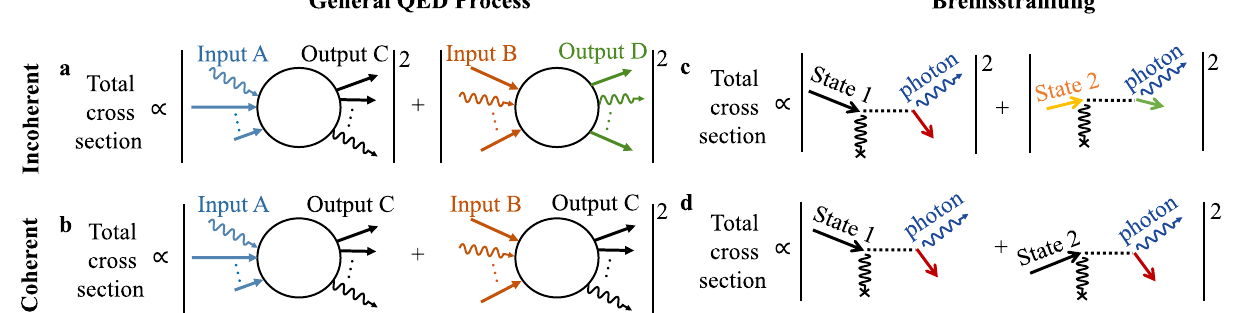
Fig. 1 Coherent and incoherent contributions in quantum electrodynamical (QED) processes. When the input to a QED process is a superposition of multiple states, e.g., 2 states (Input A and Input B), the overall cross section is typically given by the sum of the cross sections associated with each input state, as in ( a ). Then, the total cross section is proportional to the sum of the squared-modulus of all the respective scattering amplitudes. However, when the input states are chosen to yield the same output state C, the individual processes coherently interfere, as in ( b ). The result is a square of summed amplitudes in ( b ), as opposed to the sum of squared amplitudes in ( a ). Essentially, a and b illustrate the concept that multiple quantum pathways will add coherently if and only if their output is the same, regardless of how much their input differ from one another. The speci fi c case of bremsstrahlung is presented in ( c ) and ( d ) using Feynman diagrams, corresponding to the scenarios in a and b , respectively. The diagrams show the spontaneous emission of a photon from a free electron scattering off a static potential. The static potential is represented by the wiggly black line terminating in a cross. The coherent addition in b can be harnessed via free electron waveshaping as an additional degree of freedom to tailor the properties of QED processes. In bremsstrahlung, coherent interference d can lead to enhanced directionality, monochromaticity, and versatility in the photon output, as explored in Figs. 2 and